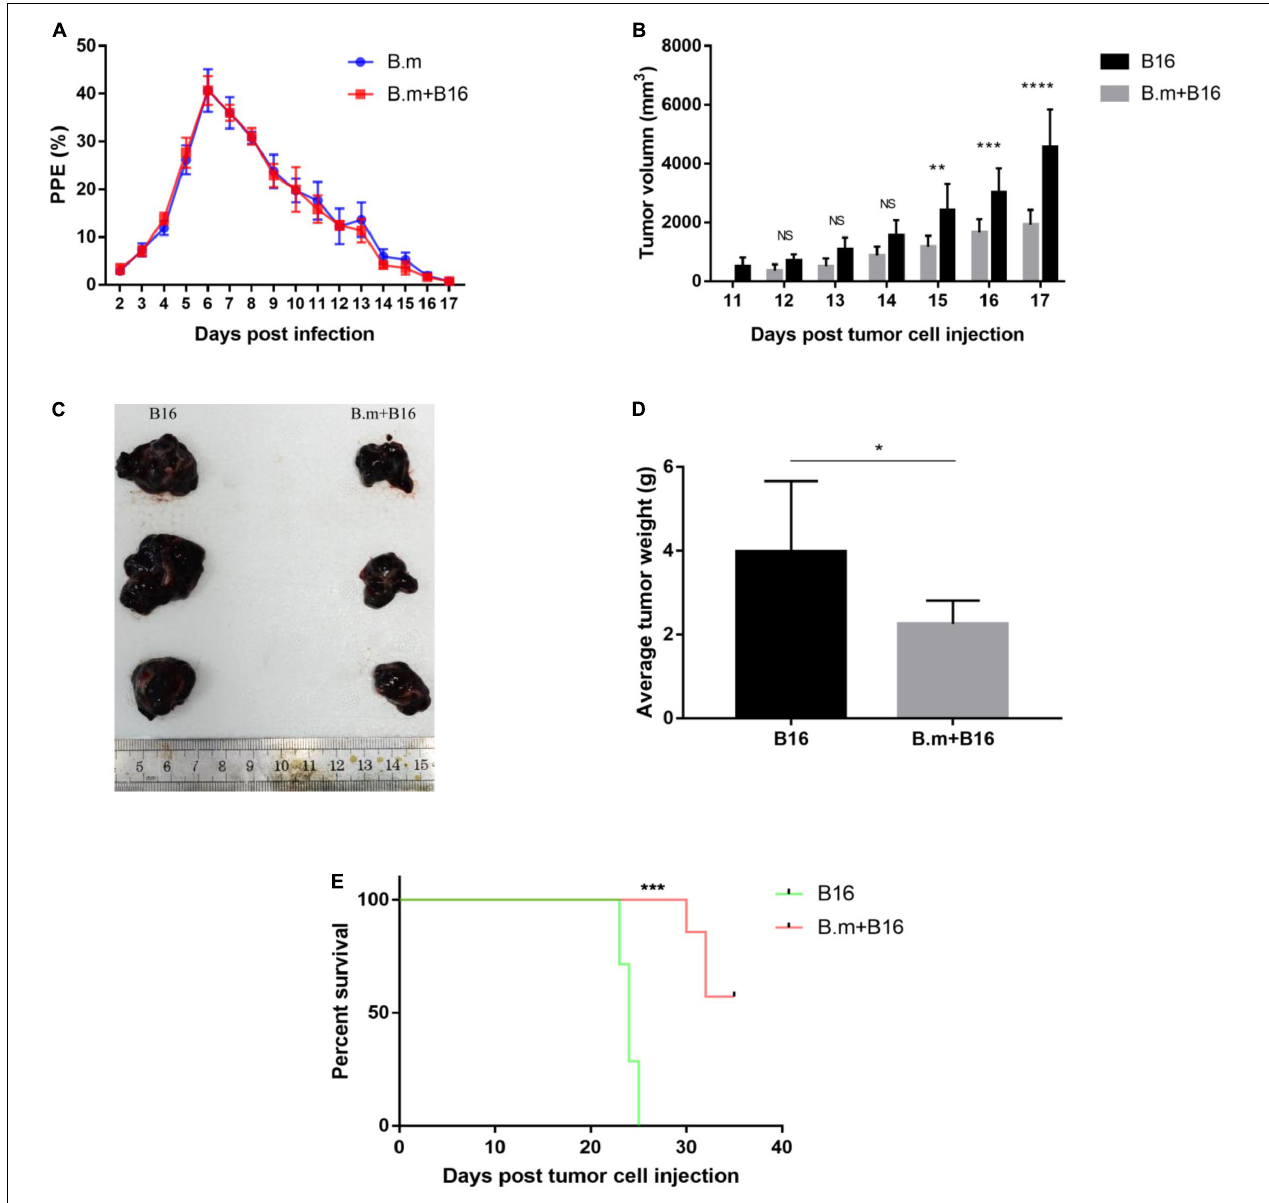
FIGURE 1 | Effects of B. microti infection on melanoma growth and survival time of tumor-bearing mice. (A) Dynamics of parasitemia measured by blood smear in B. microti- infected mice. (B) Growth kinetics of subcutaneous tumor in B. microti infected and uninfected tumor-bearing mice. (C) Tumor size of part of mice. (D) Weight of subcutaneous tumor at day 17 post-tumor cell injection. (E) Survival curve of tumor-bearing mice from day 0 to 35 post-tumor cell injection. Error bars are SD; * p ≤ 0.0332, ** p ≤ 0.0021, *** p ≤ 0.0002, **** p ≤ 0.0001. There were seven mice in each